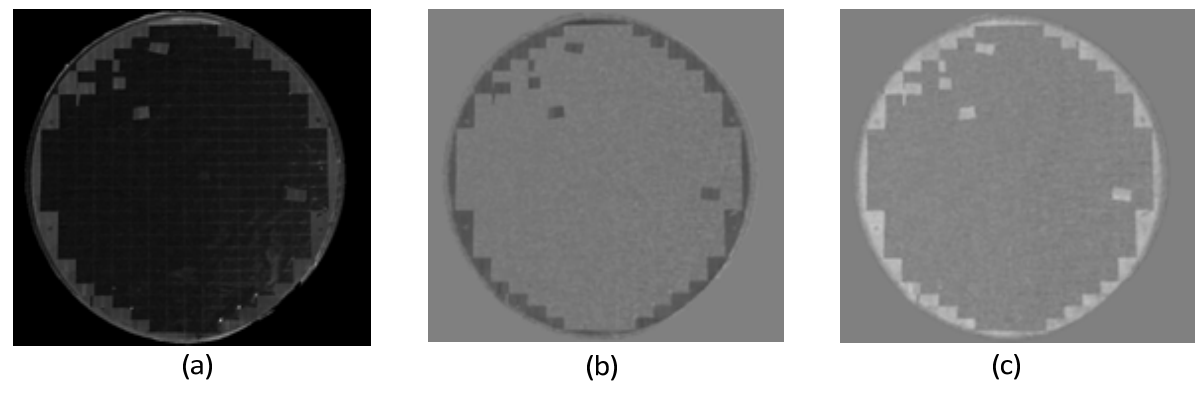
Figure 6. ( a ) The Y component image; ( b ) the Cb component image; ( c ) the Cr component image in the YCbCr color space.